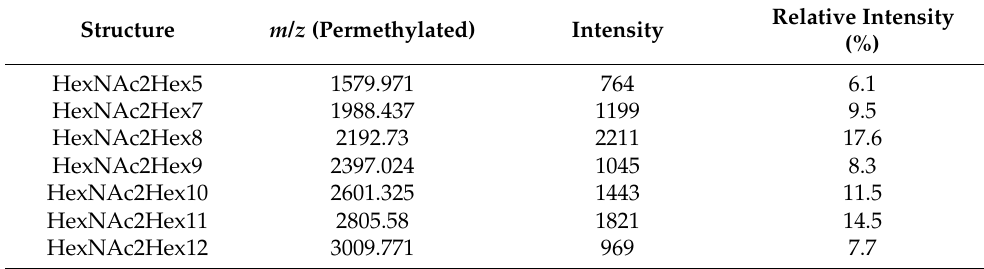
Table 1. Main N-glycoforms detected in recombinant human CP.